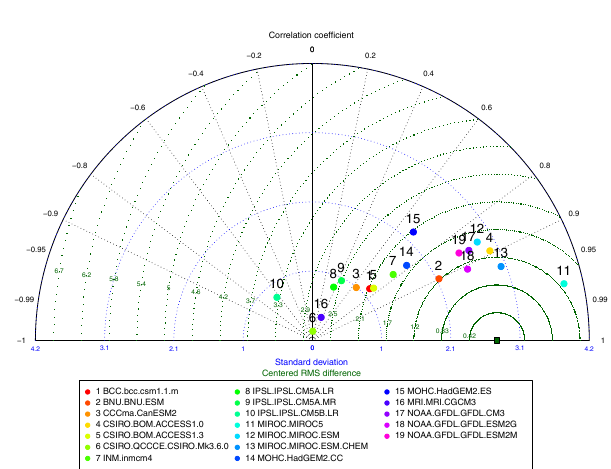
Figure A1. Taylor diagram that graphically summarises how closely the historic precipitation generated by each of the 21 CMIP5 models used in this study matches the TRMMv7 observed precip- itation, over the period 2000–2005. According to that diagram, the closer a model is to the observation (dark green – squared dot in the bottom right side of graph), the better it